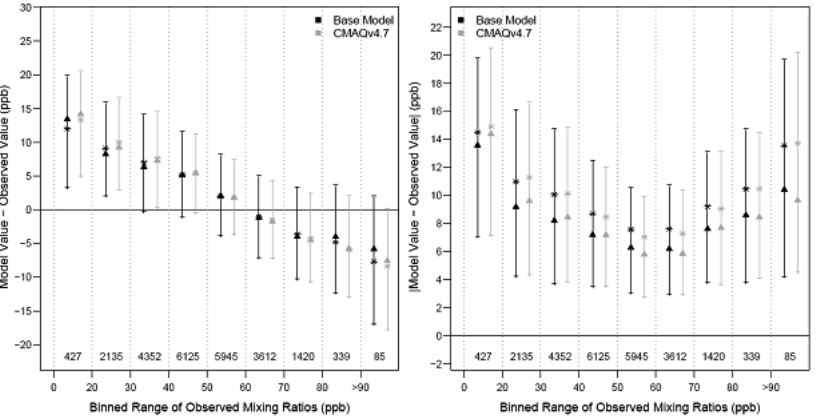
Fig. 11. Mean (star), median (triangle), and inter-quartile ranges of model bias (left) and absolute model bias (right) binned by observed ozone mixing ratios for August 2006. The number of model/observation pairs for each bin is shown above the x-axis.